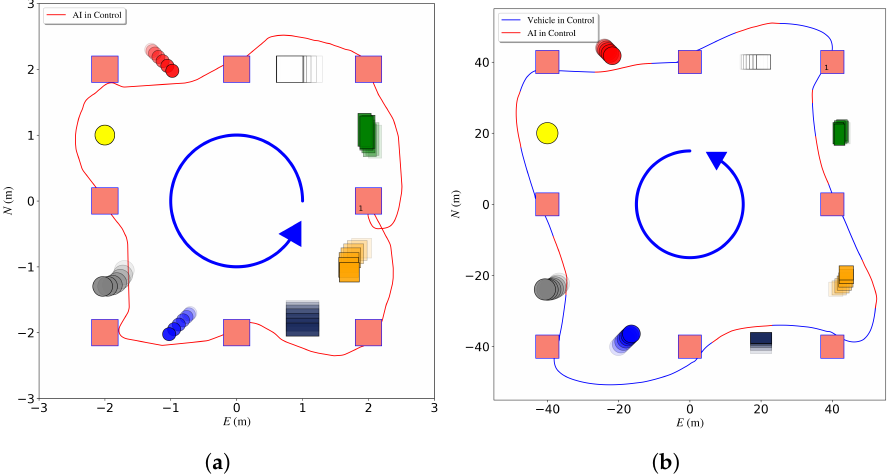
Figure 10. Simulated obstacle avoidance mission showing mission waypoints as red squares, obstacles in different colors, vehicle trajectories in blue when the DRL is activated and trajectories in red when the DRL is activated. The trajectory runs counter-clockwise starting from waypoint 1. ( a ) UGV evaluation in simulation. ( b ) USV evaluation in